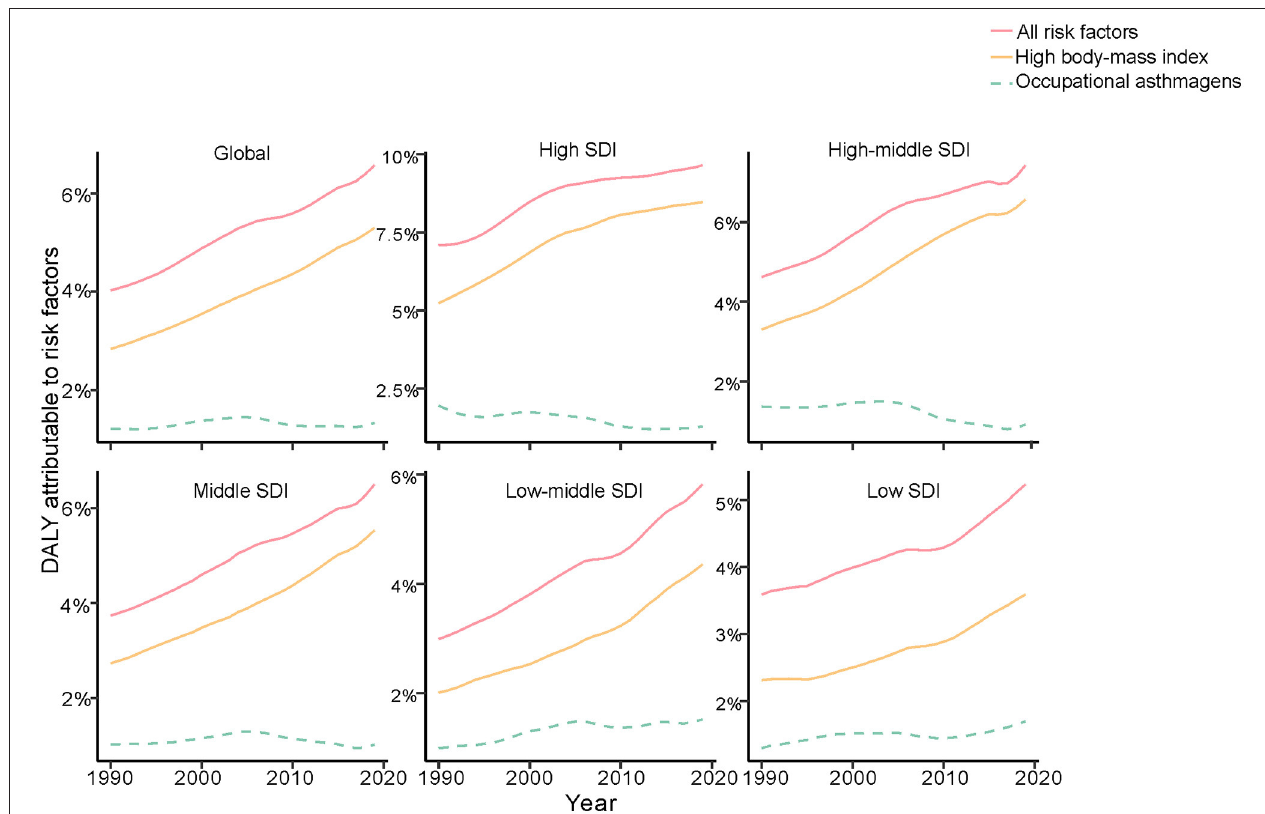
FIGURE 7 | Fraction of age-standardized DALYs attributable to high BMI and occupational asthmagens in childhood asthma by age group, 1990–2019. DALYs, disability adjusted life years; BMI, high body mass